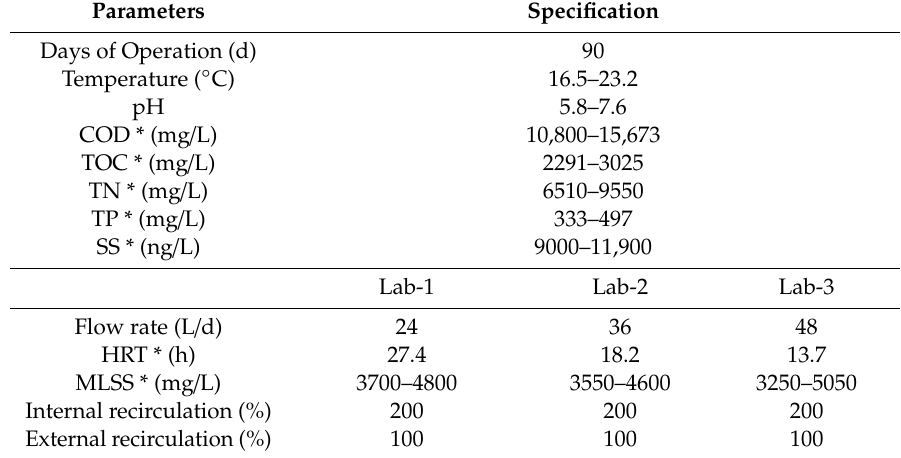
Table 5. Laboratory-scale experimental